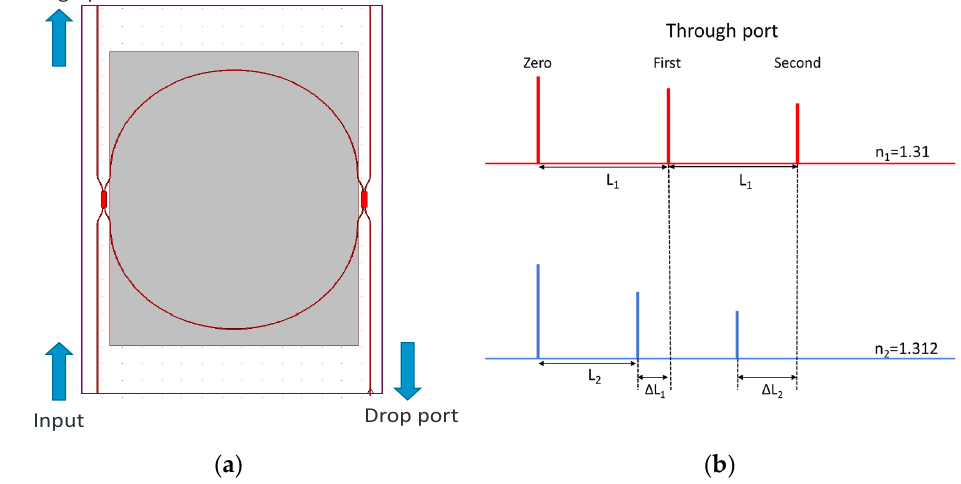
Figure 1. ( a ) MMI-coupled MRR with through and drop ports. ( b ) MRR interferograms.